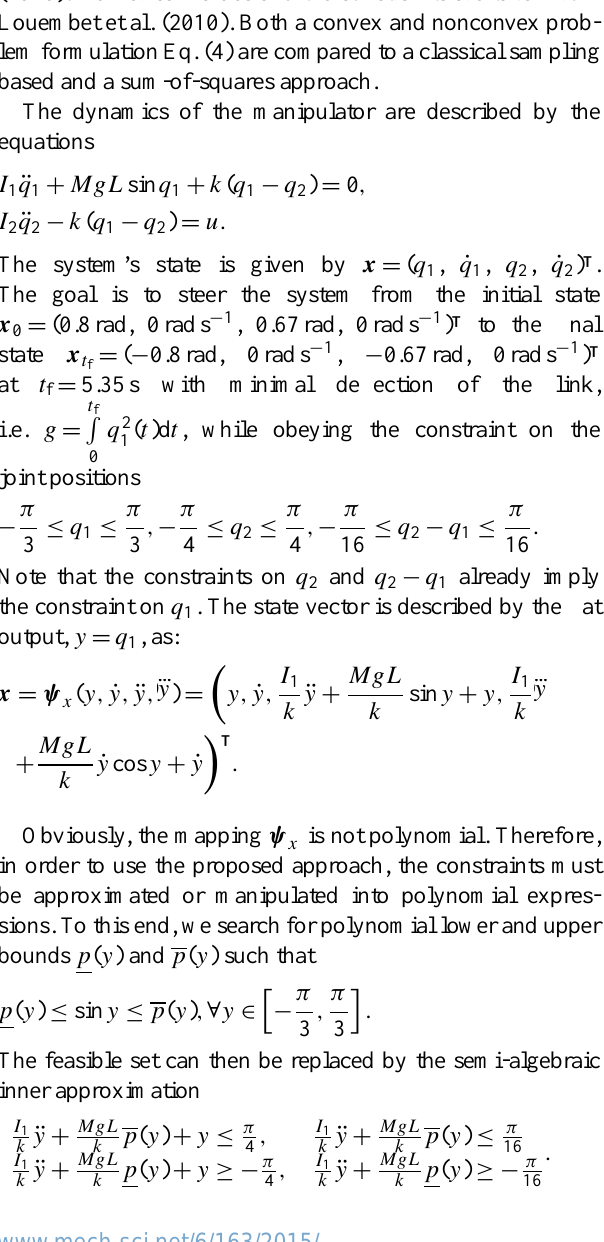
Figure 2. Refining the control polygon brings the control polygon closer to the spline: (a) the original spline, (b) one knot insertion and (c) elevate order by one. Note that knot insertion acts locally, while order elevation changes the control polygon globally.